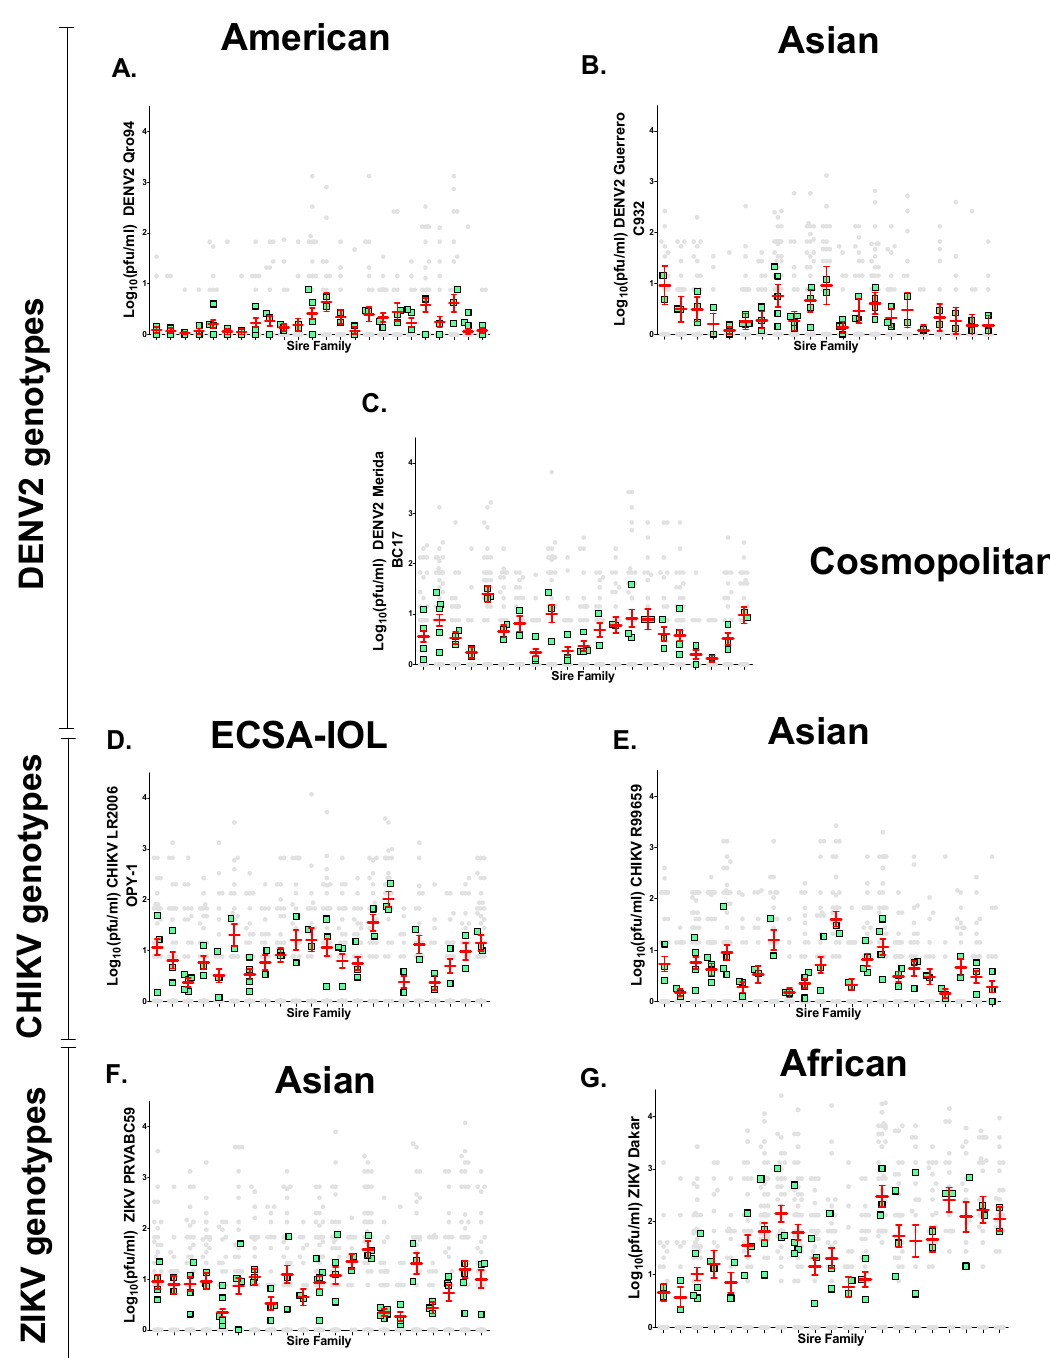
Figure 8. Distribution of phenotypes log 10 (PFU/mL) per saliva in half-sib families for the seven virus strains. Each column of points arising from the X-axis represents a sire family. In each column, the distribution of individual saliva titer arising from that sire appear as gray circles. Mean sire values and their 95% confidence intervals are displayed in red. The mean of dam families in each sire appear in green. ( A ) DENV2 American genotype, ( B ) DENV2 Asian genotype, ( C ) DENV2 Cosmopolitan genotype, ( D ) CHIKV ESCA-IOL genotype, ( E ) CHIKV Asian genotype, ( F ) ZIKV Asian genotype, and ( G ) ZIKV African